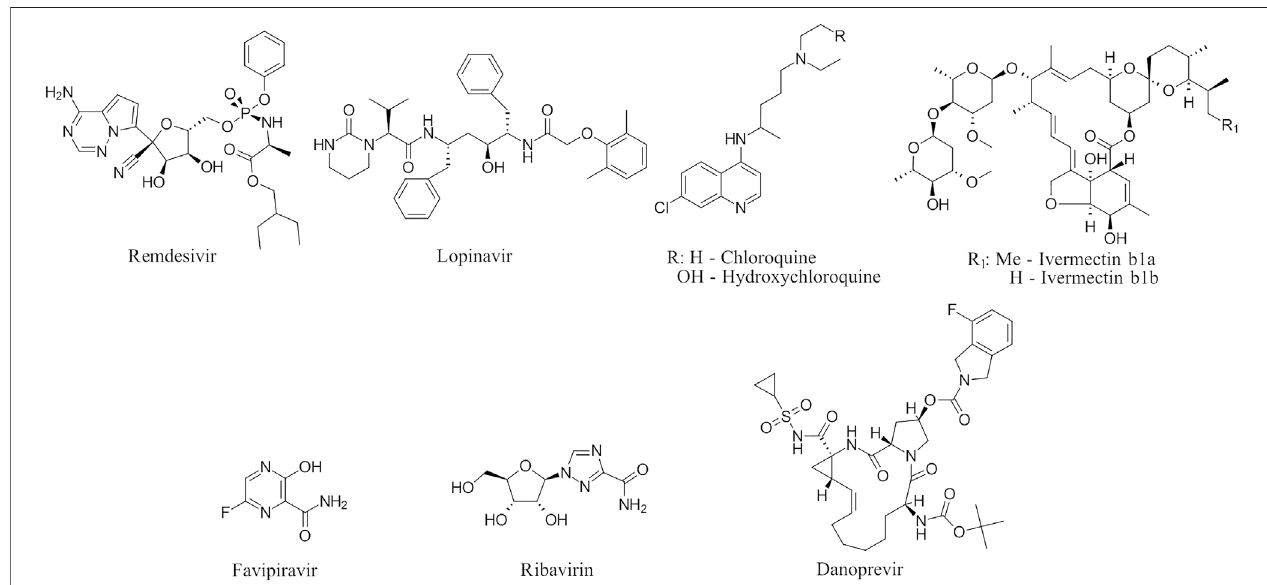
FIGURE 1 | Commonly repurposed drugs against SARS-CoV-2 with proposed direct action (ritonavir is mainly a pharmacokinetic modi fi er for its partner in combination therapy).